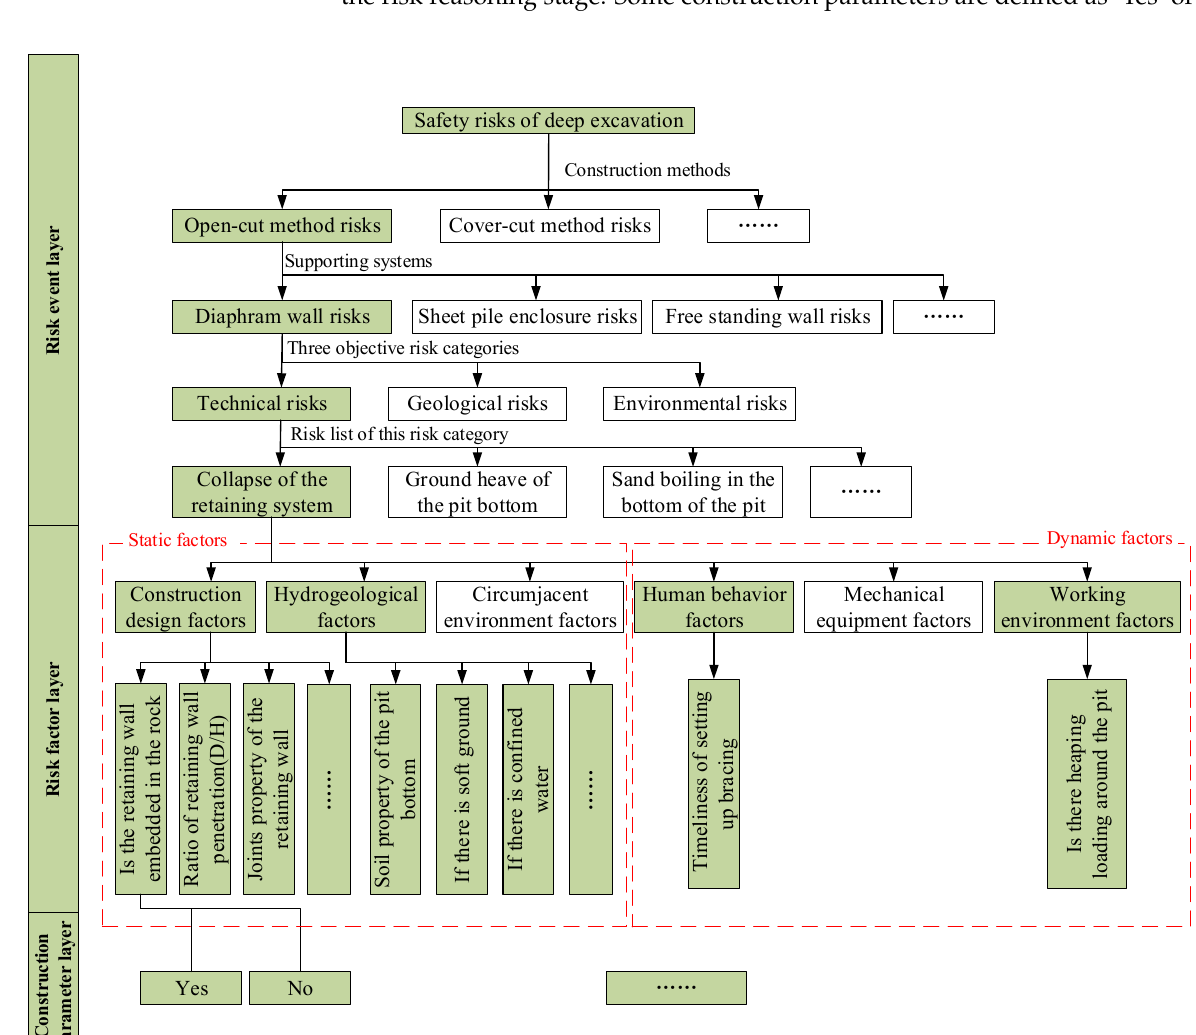
Figure 2. Information requirement model for safety risk identification in deep excavation.